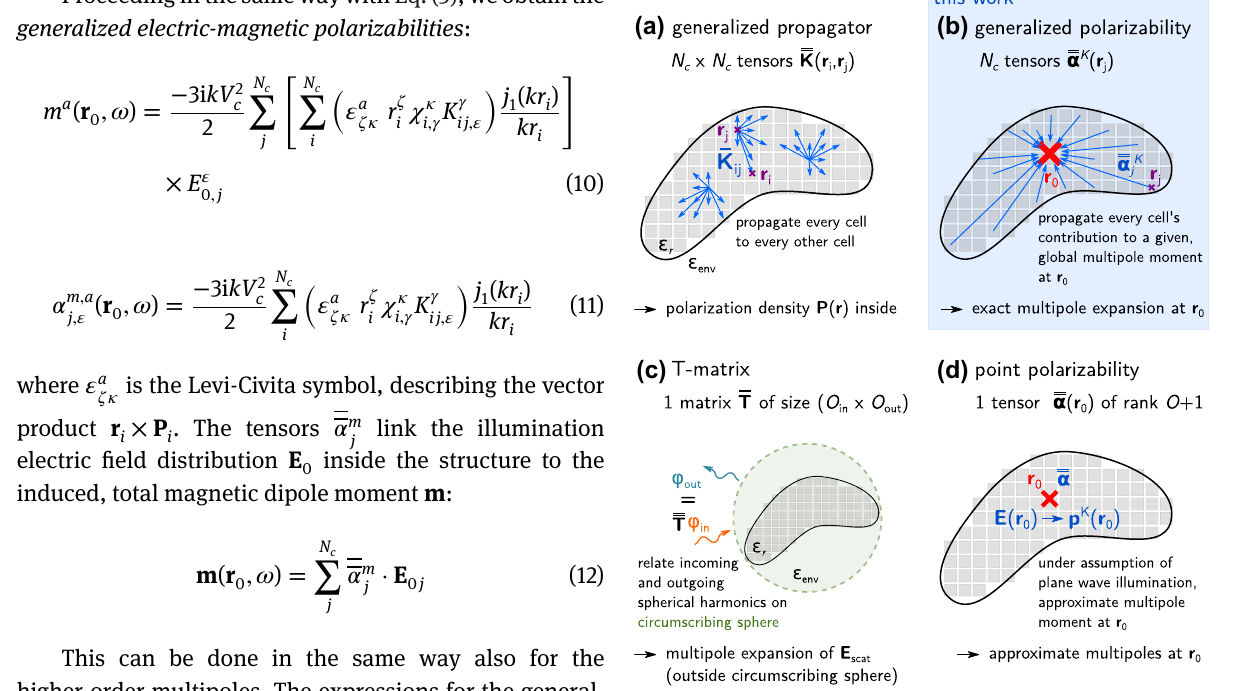
is placed in an Figure 2: A particle of relative permittivity 𝜀 r , and its volume is discretized on a environement of permittivity 𝜀 env regular mesh. (a) The generalized field propagator K establishes a relation between the illumination field inside the structure and the spatial distribution of the electric polarization by propagating the zeroth-order dipole moment of each meshcell to the locations of all other meshcells. (b) The generalized polarizabilities 𝜶 K , presented in this work, propagate the zeroth-order dipole moments of all of the multipole expansion. It thus meshcells to the location r 0 represents each meshcell’s contribution to the total multipole moment. The superscript K indicates the type of multipole moment (e.g. electric or magnetic dipole or quadrupole). For illustration, only a few propagation vectors are shown. (c) The T-matrix establishes a relation between expansion coefficients of incoming and outgoing , respectively (scattered) spherical vector harmonics (denoted as 𝜑 in 𝜑 ). Fields are valid outside the circumscribing sphere. (d) Point out polarizability models approximate the multipole moment ( p K ) under the assumption of plane wave illumination.